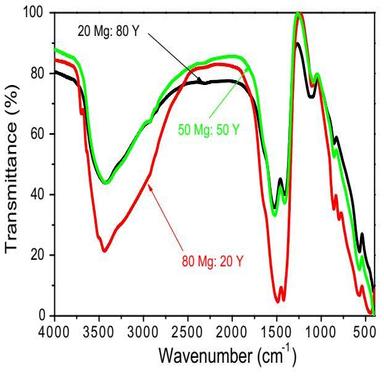
FT-IR spectrum of the produced magnesium yttrium oxide precursors at different Mg2+ ion ratios.